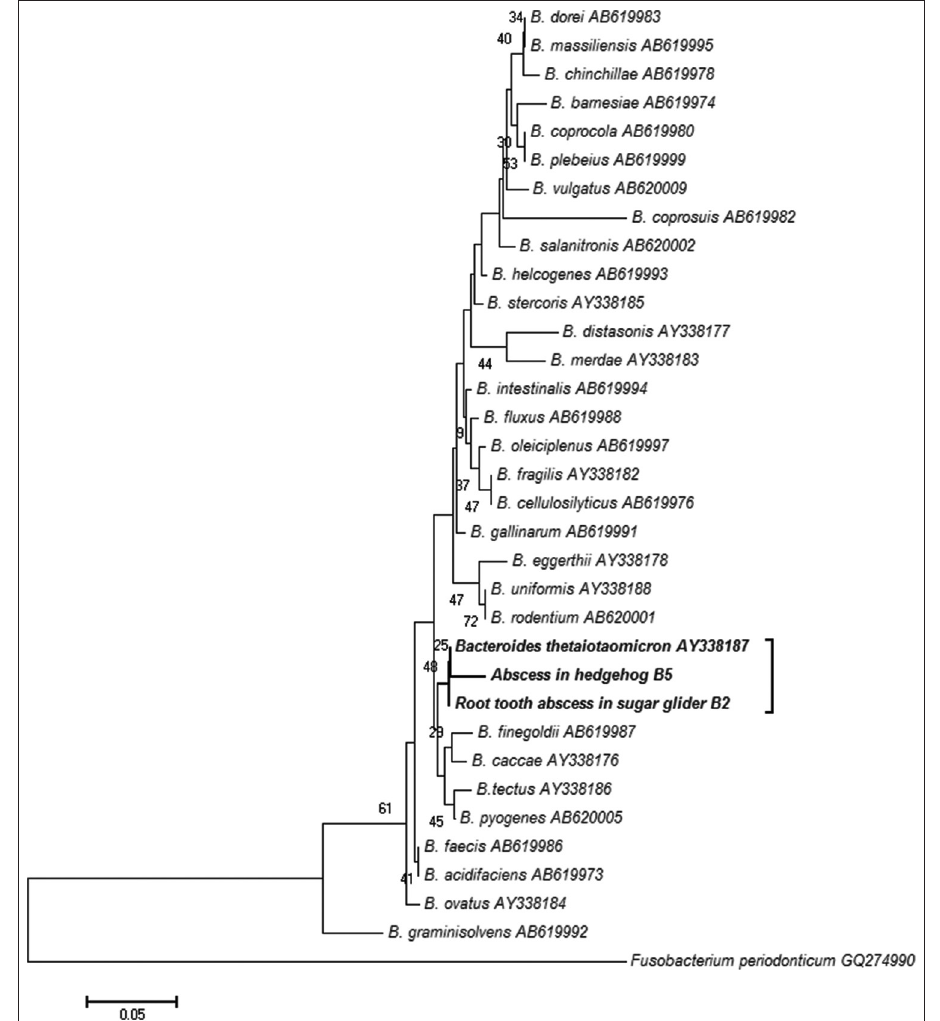
Figure-3: Neighbor-joining phylogenetic tree of the rpoB gene of Bacteroides spp . detected in the abscesses and validated genotypes of Bacteroides spp . (GenBank accession number; MG917665-MG917666). Percentage bootstrap support from 1000 pseudoreplicates is indicated to the left of the supported